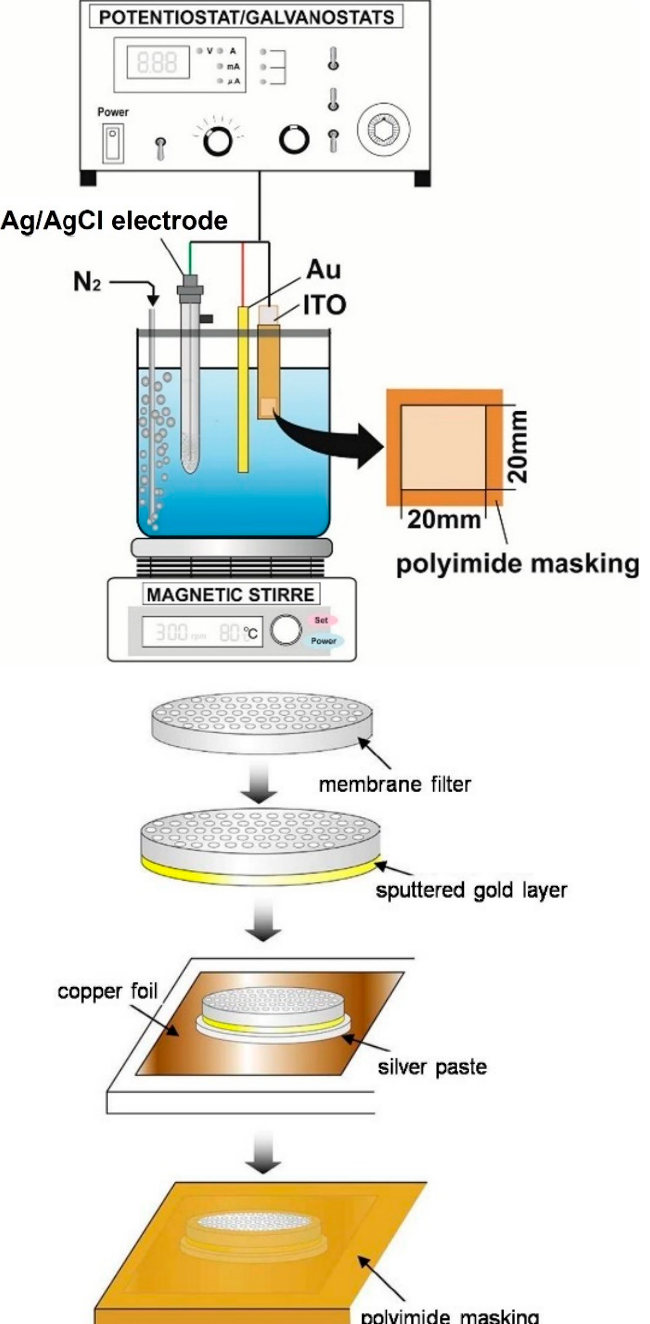
Figure 7. Fabrication process of ZnTe nanowires array using a template electrodeposition technique. Commercially available ion-track etched polycarbonate membrane filters were used as a nanochannel template. The aqueous electrolytic solution was synthesized from ZnSO 4 · 7H 2 O (0.1 M), TeO 2 (0.002 M), sodium sulfate (0.5 M), citric acid (0.05 M), and sodium citrate (0.05 M). The solution pH and temperature were set to ca. 4.0 and 313 K, respectively.